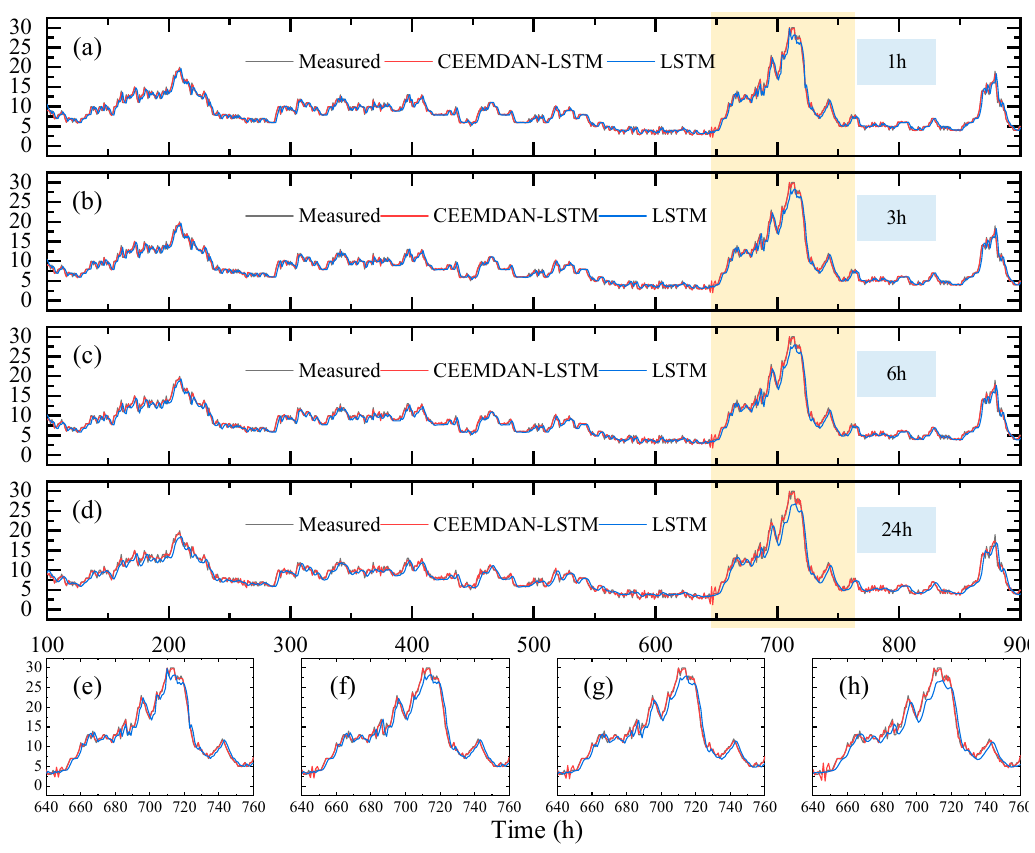
Figure 12. Comparison of LSTM (blue) and CEEMDAN-LSTM (red) SWH (m) forecasts with ( a ) 1-, ( b ) 3-, ( c ) 6- and ( d ) 24-h window measured values (black). Subplots provide a closer examination of the offset between measured and predicted values in ( e ) 1-, ( f ) 3-, ( g ) 6- and ( h ) 24-h